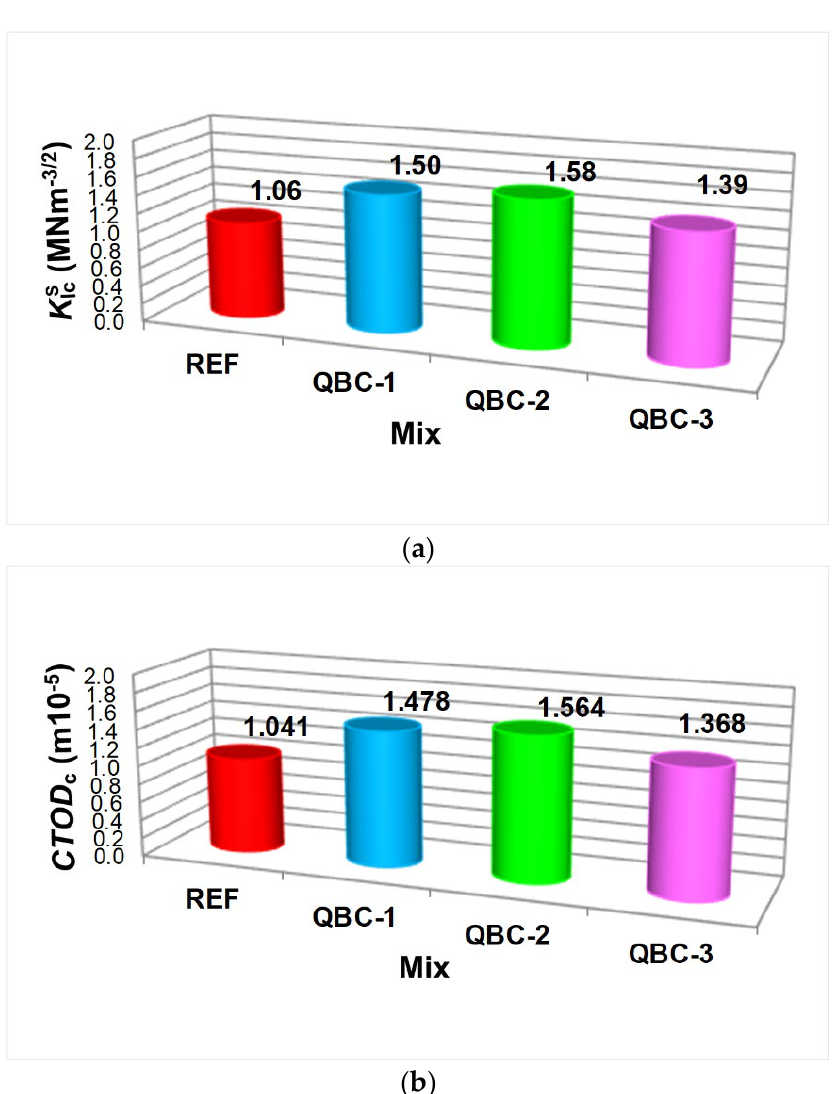
, ( b ) , ( b ) CTOD c Ic IcS 𝐾𝐾